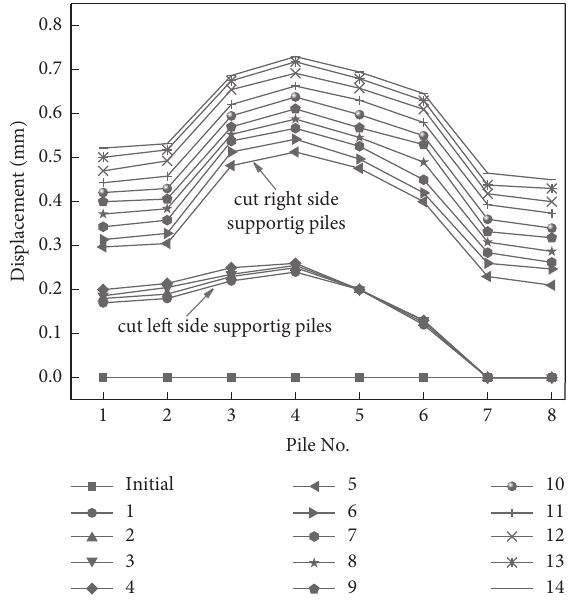
Figure 12: Deformation of supporting piles at